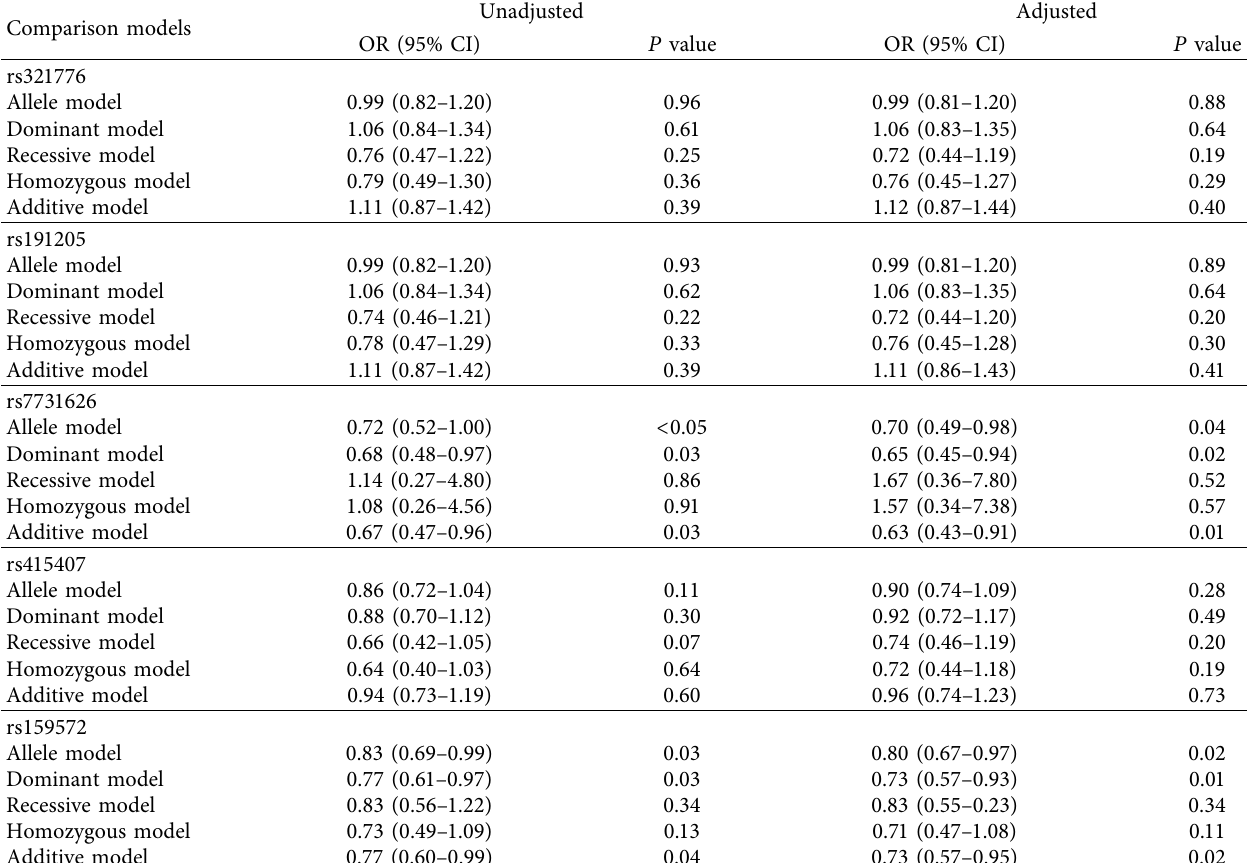
Table 4: Odds ratios (ORs) of the associations of five polymorphisms in the ANKRD55 gene with HT before and after adjusting for age and